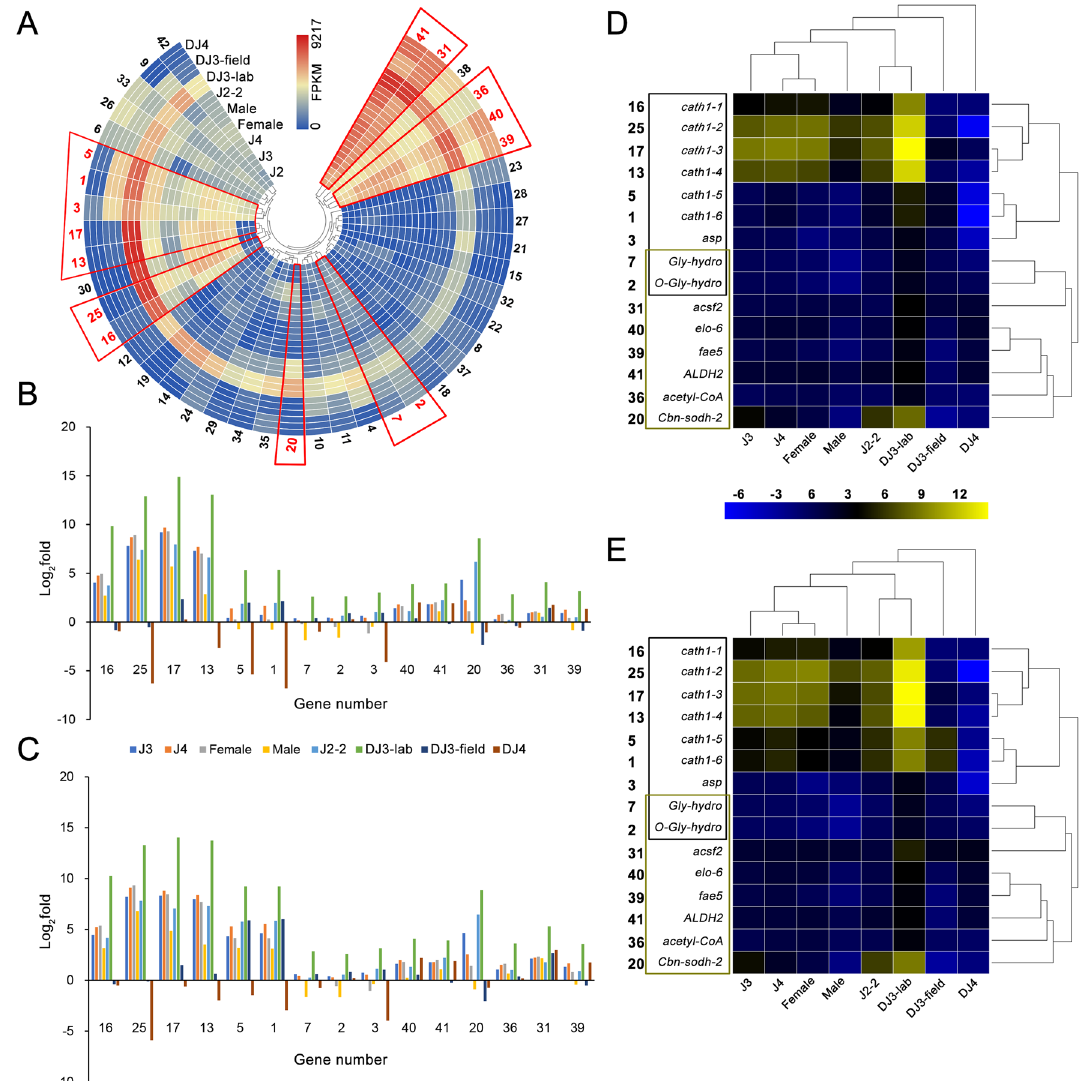
Figure 4. The expression pattern of 7 CATH1 homologous genes with the top 30 highest GS values to the DJ3-lab and their top 30 related genes in the pink module. ( A ) The expression (FPKM) of 42 genes in the pink module include 7 CATH1 homologous genes with the top 30 highest GS values to the DJ3-lab and their top 30 related genes. Genes are clustered by their expression pattern. The 15 genes associated with lipid metabolism or autophagy are framed in red. ( B ) Comparison of the relative transcript abundances of the 15 lipid metabolism- or autophagy-associated genes from different PWN stages (normalized by J2) by FPKM. ( C ) Comparison of the relative transcript abundances of the 15 lipid metabolism- or autophagy-associated genes from different PWN stages (normalized by J2) by RT-PCR. ( D ) Heatmap and clustering analysis of the results from ( B ). ( E ) Heatmap and clustering analysis of the results from ( C ). Genes in the black box are associated with autophagy, while those in the khaki box are associated with lipid then screened the top 30 highest weight value genes for each of these 7 genes in the pink module. In total, 42 genes with 210 regulations were obtained. Of these 42 genes, 15 were related to autophagy or lipid metabolism. These included 6 of the 7 genes that were highly homologous to the CATH1, and these 6 genes were all highly related to autophagy. Although the expression patterns of the functionally similar genes of the 15 genes were highly similar, there was a high correlation between the 15 genes. There was an increase in hub genes involved in autophagy-related genes, and these genes had a relatively higher correlation with other genes, suggesting that autophagy might play an important role in DJ3 to promote the formation of DJ3 and maintain its longevity by regulating genes related to lipid metabolism. Under normal conditions, autophagy occurs at the basal level. However, it is accelerated by a variety of stresses, such as starvation 31 , the accumulation of abnormal proteins and organelle damage 32 . Thus far, accumu- lating evidence shows that the activation of autophagy seems essential for longevity 31,33–35 . Autophagic activity is commonly elevated in many long-lived animals and is essential for their longevity, suggesting that autophagy